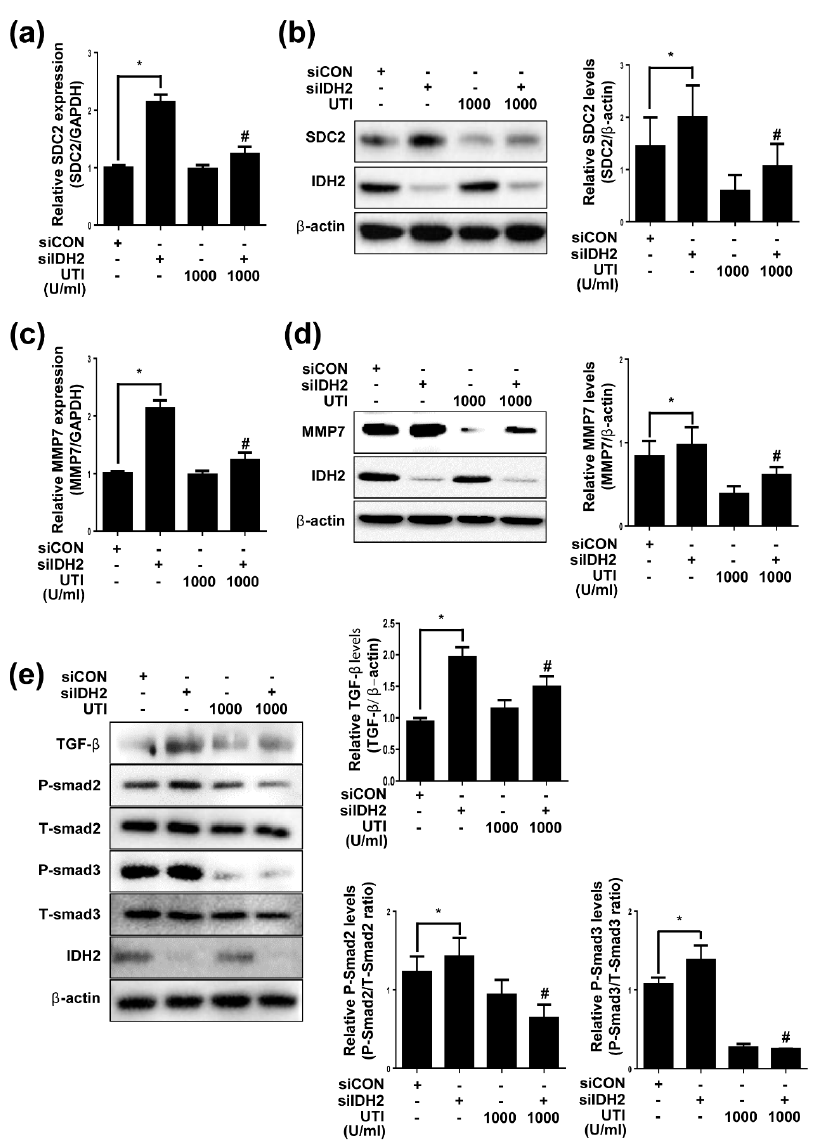
Figure 3. Effect of UTI on SDC2, MMP7 and TGF- β signaling in IDH2 deficient HUVECs. HUVECs were transfected with 50 pmol of siIDH2 and siCON and 1000 U/mL of UTI. mRNA expressions of ( a ) SDC2 and ( c ) MMP7 were quantified by qPCR. Protein levels of ( b ) SDC2 and ( d ) MMP7 were detected by western blotting. ( e ) Protein level of TGF- β signaling was detected by western blotting. β -actin was used as a loading control. Protein levels were quantified by densitometric analysis using Image-J software (Shown in the right panel). All data are presented as means ± SEM of three independent experiments, * p < 0.05, compared with siCON, # p < 0.05 compared with the 50 pmol siIDH2 treated cells.